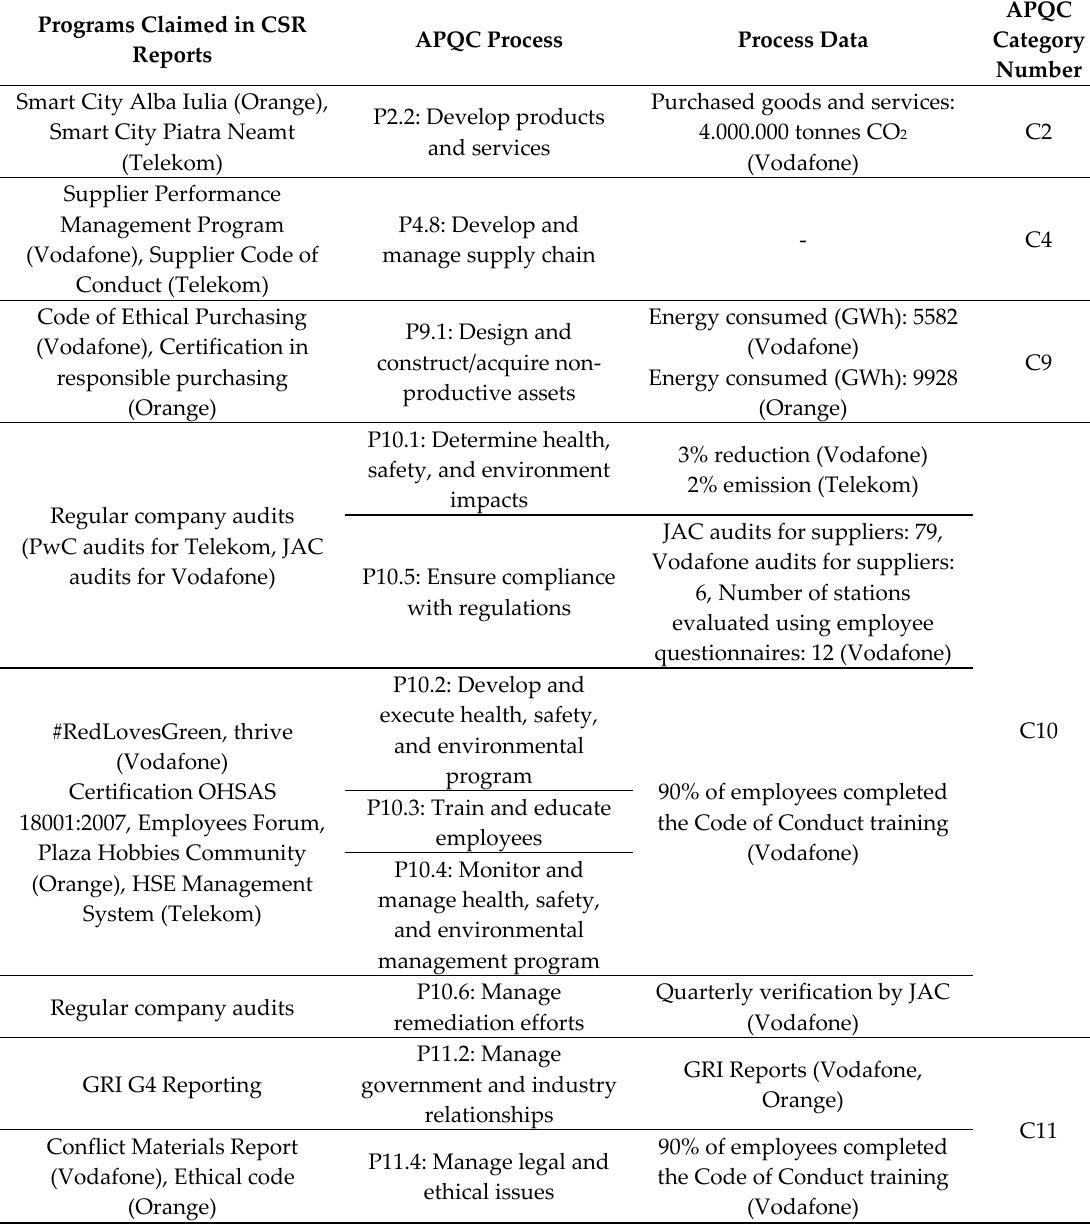
Table 1. Groups of business